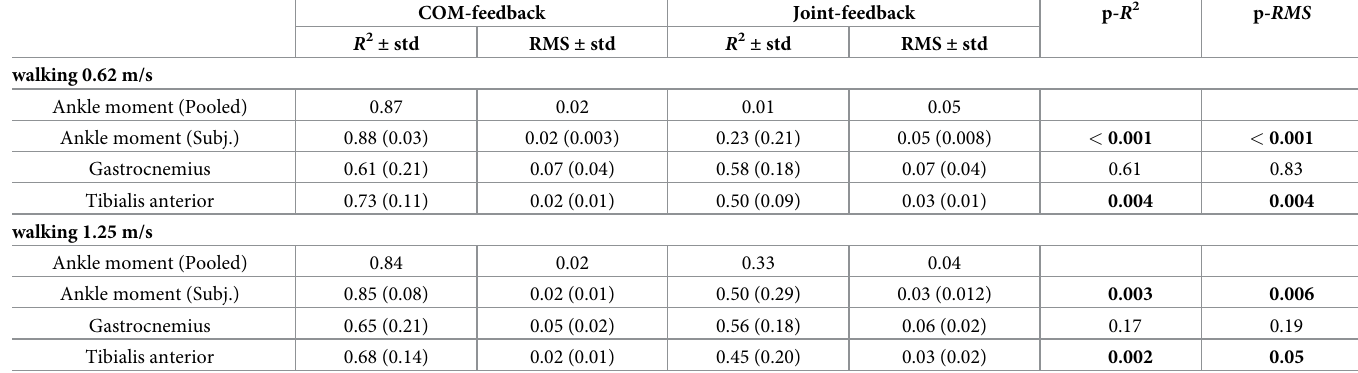
Table 2. Pelvis push perturbations walking (data from [9]). RMSE and R 2 of the linear regression between delayed COM kinematics and reactive ankle muscle activity in perturbed walking. Joint moments are reported pooled over all subjects (Pooled) and for individual subjects (Subj.) with the standard deviation over subjects (std). P-values are reported of the paired ttest that compares the model with COM feedback and the model with ankle joint kinematics feedback. The results of muscle activity are only reported for individuals and not pooled over all subjects due to the limitations related to normalizing electromyography data.